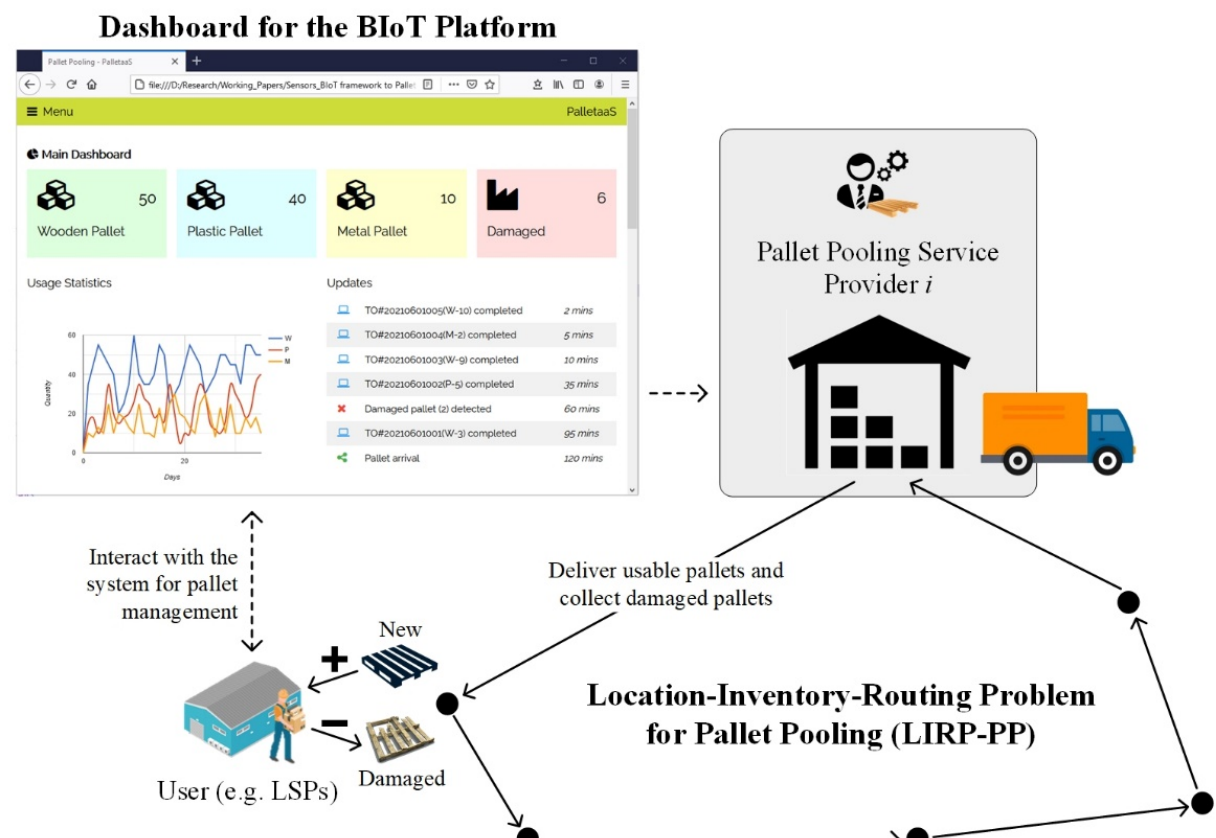
Figure 4. Modelling of the location ‐ inventory ‐ routing problem for pallet pooling.